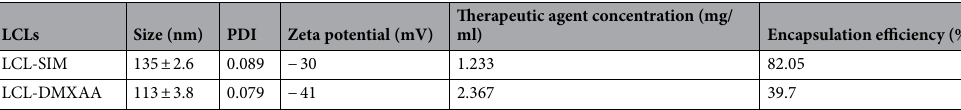
Table 2. Characterization of LCL formulations encapsulating SIM or